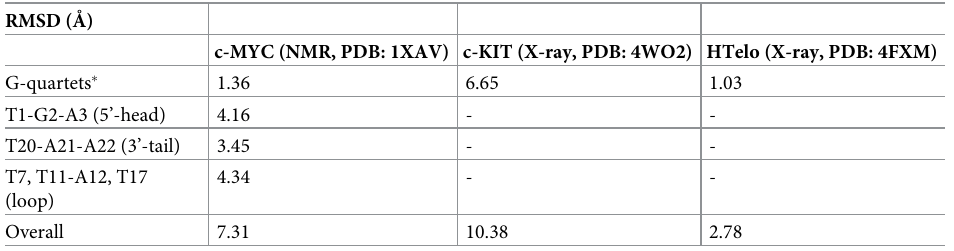
� G-quartets are comprised of G4-G5-G6, G8-G9-G10, G13-G14-G15, and G17-G18-G19. RMSD comparisons were not made between distinct quadruplex structures (c-KIT, telomeric) for the loop, head and tail regions due to significant sequence